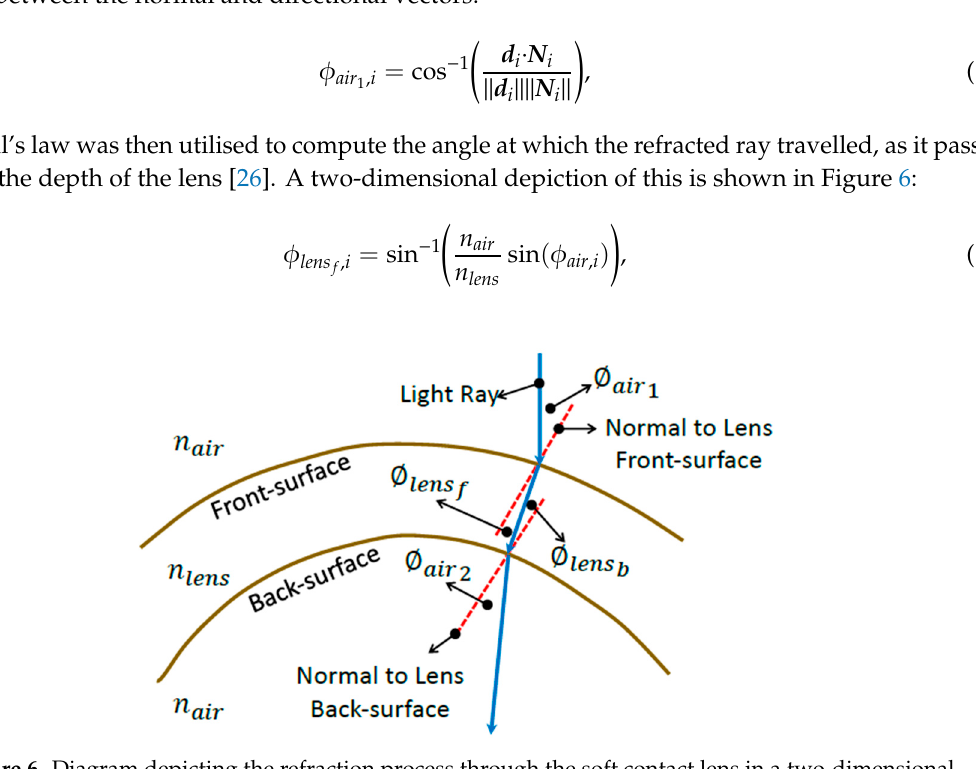
Figure 6. Diagram depicting the refraction process through the soft contact lens in a two-dimensional sketch for simplification purposes.